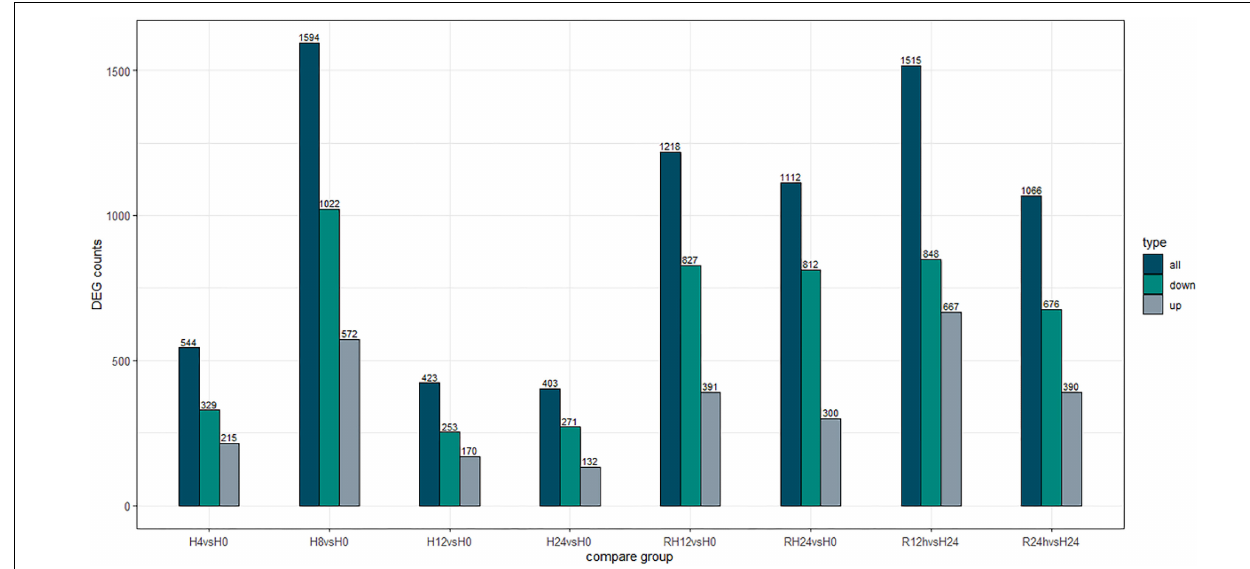
FIGURE 1 | Number of differentially expressed genes under different hypoxic stress time.